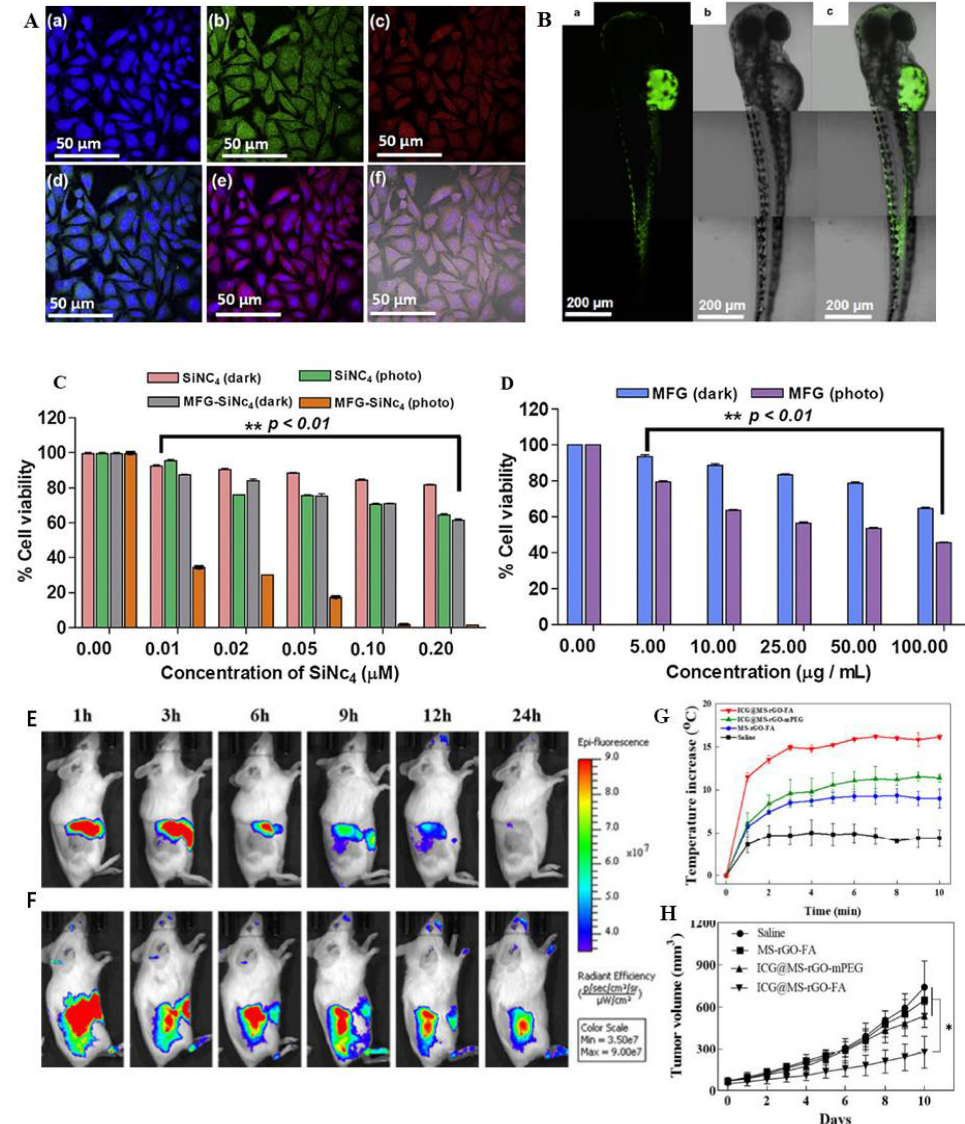
Figure 5. CLSM images of functionalized graphene composites. ( A ) In vitro images of MFG-SiNC 4 in HeLa cells where the images reveal very good biodistribution throughout the cell (( a ) control stained with DAPI, ( b ) green, and ( c ) red emissions from the MFG-SiNC 4 and, ( d , e ) are the combined images of ab andac. ( f ) The combined images of abc with DIC). ( B ) In vivo whole-body zebrafish images with MFG, where the green fluorescence is observed throughout the body due to its very good bio-distribution [70,95]. ( C , D ) The combined PTT/PDT and PTT of MFG-SiNc 4 and MFG [70,95]. ( E , F ) Time dependent in vivo mice non-targeting and targeting images of MS-RGO-ICG-PEG and MS-RGO-ICG-PEG-FA. The image taken at 24 h reveals that the FA functionalized GO, ( E ) has shown bright luminescence and very good tumor specificity whereas it is not observed in non FA targeted GO ( F ). ( G ) Time vs. temperature at tumor bearing mice. ( H ) Tumor volume after irradiation with laser up to 10 days [97]. Reprinted/adapted with permission from Refs. [70,95]. Copy right 2012 and 2014, copyright Elsevier. Reprinted/adapted with permission from Ref. [97]. Copy right 2022, copyright MDPI. 3.2. MRI for Imaging Guided Therapy Among all imaging techniques, MRI and CT scans are clinically versatile and best used so far for imaging-based diagnosis purpose. These techniques do not rely on any fictionalization of fluorophores and QDs. MRI works based on the radio waves and magnetic field to identify damaged (cancer) tissue from the healthy tissues based on activating the local proton environment. It has the great advantage of ease of use for